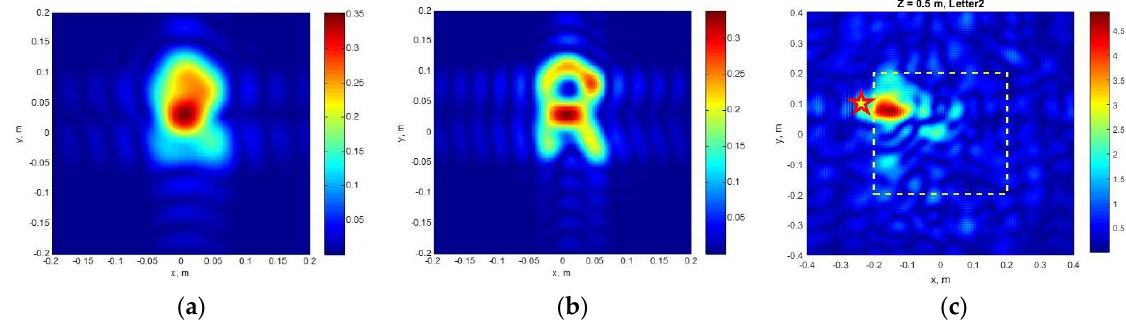
Figure 12. Calculated images of the test object at a distance l = 50 cm in free space ( a ) and in a material medium with the interface at z 0 = 30 cm and dielectric permittivity ε = 9 ( b ); an attempt to visualize an object immersed in a medium with such parameters—experiment ( c ). The asterisk and dashed line show the transmitter and the receiver antenna aperture.